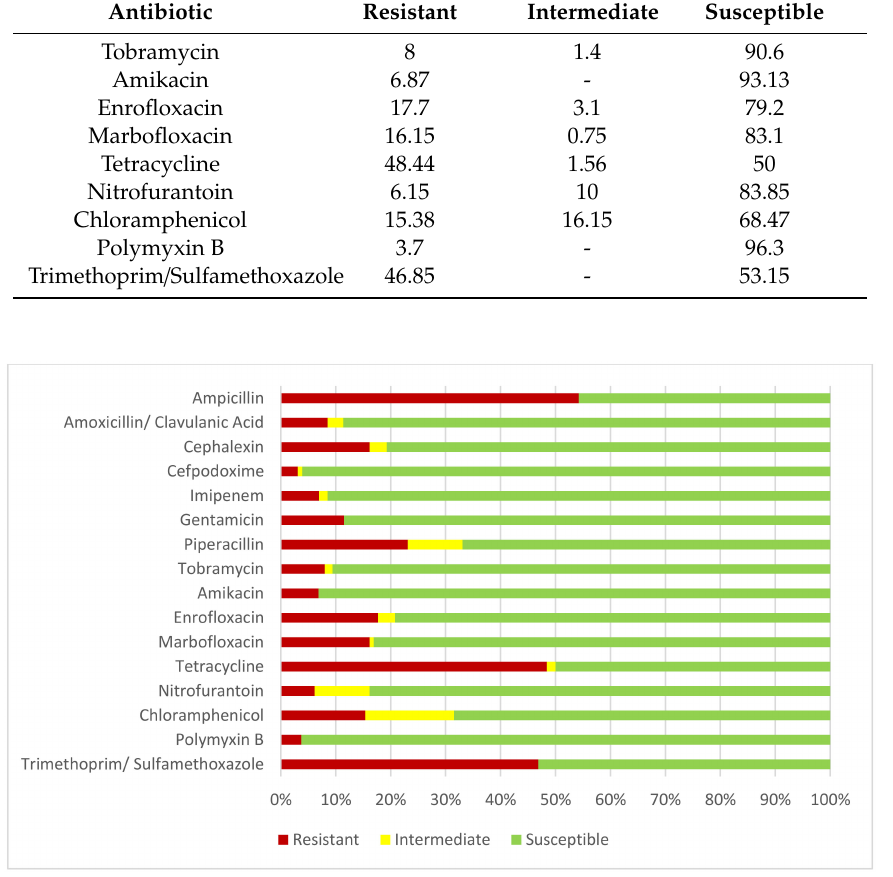
Figure 2. Global results of susceptibility tests. Antimicrobial susceptibility (%) of all isolates tested. Variations in susceptibility percentages during the three years of the study are shown in Table 2 and Figure 3. From 2015 to 2017, a sharp decrease in susceptibility was found for cephalexin, piperacillin, tetracycline, nitrofurantoin and chloramphenicol. On the other hand, an increase in the percentages of susceptibility to enrofloxacin and marbofloxacin was observed. Table 2. Variations in the percentages of susceptibility during the three years of the